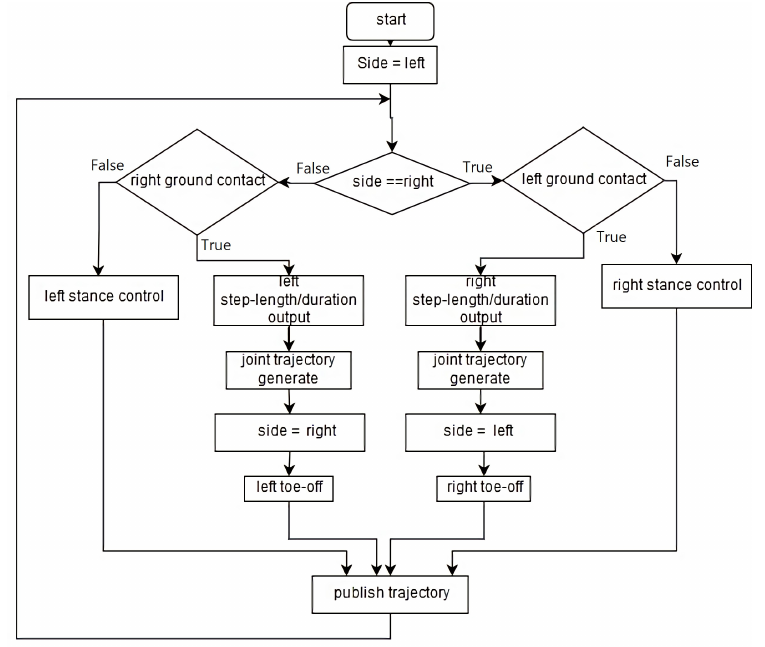
Figure 2. Flow diagram of the control system